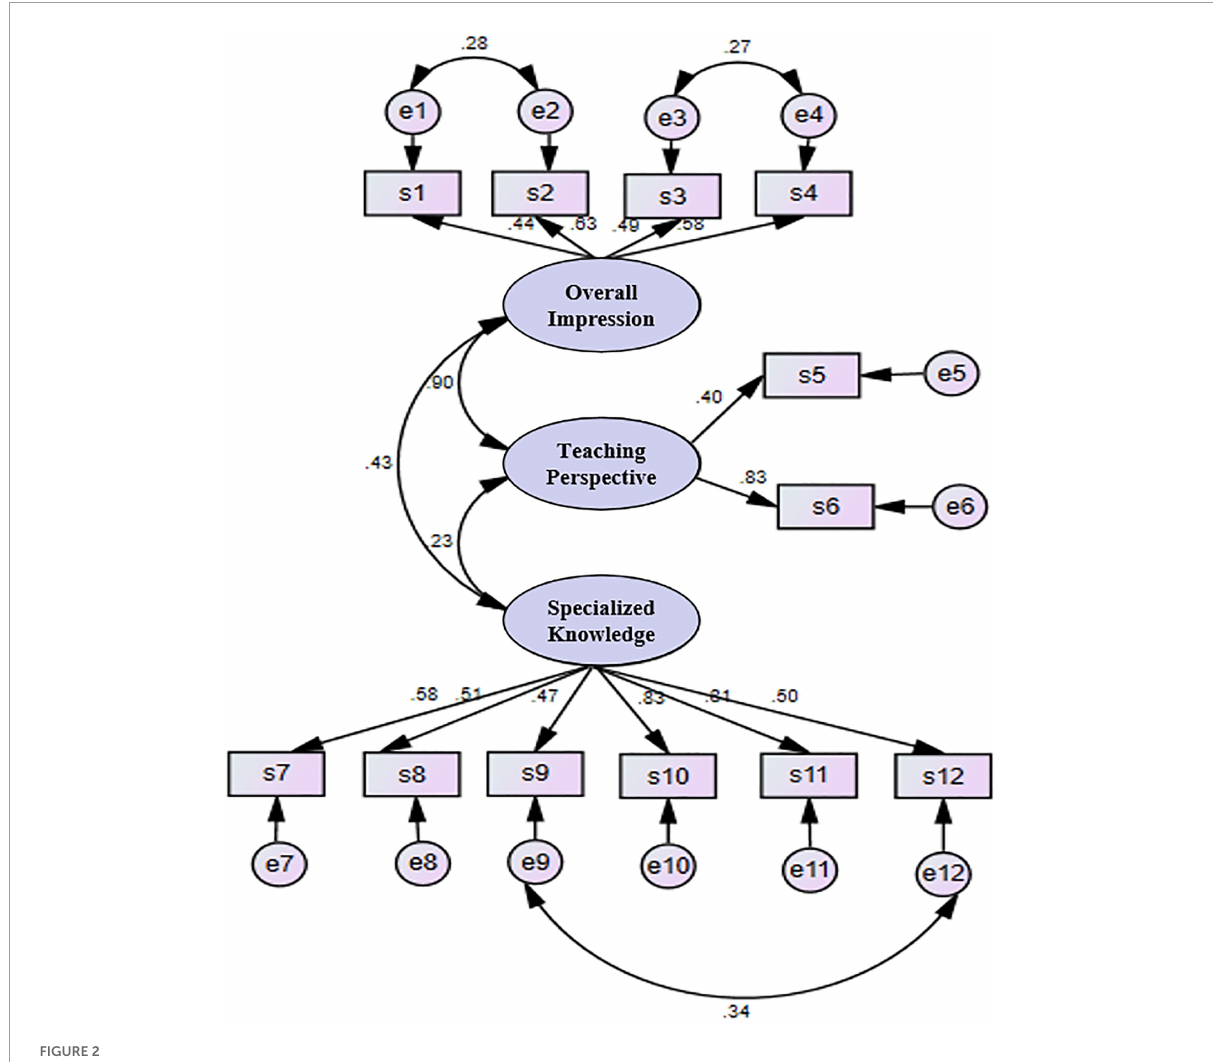
FIGURE2 Cognitive model of problem solving and its teaching.